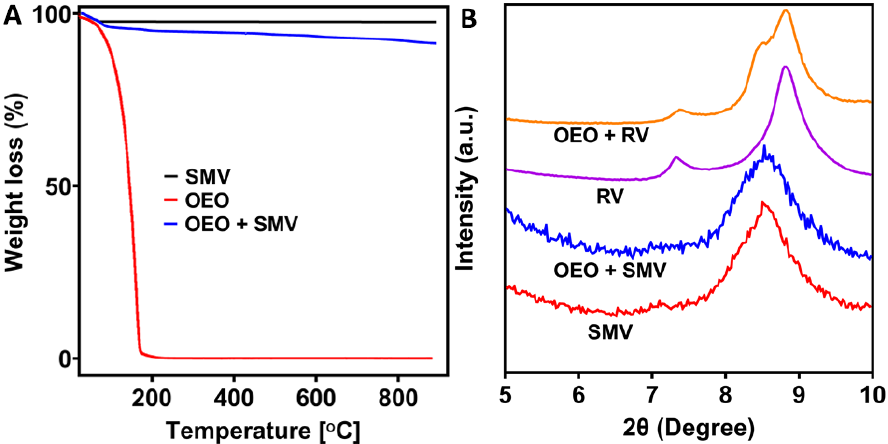
Figure 5. TGA ( A ) and SA-XRD patterns ( B ) of SMV before and after OEO loading.